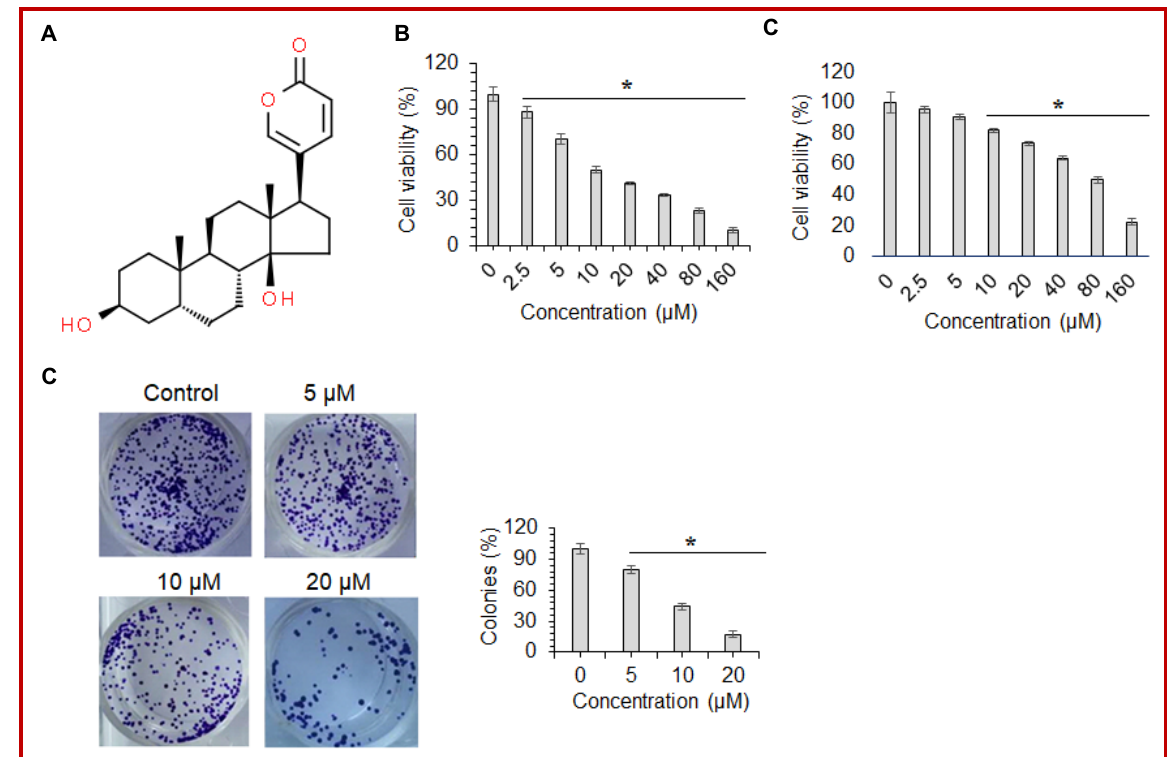
Figure 1: Bufalin exhibits selective antiproliferative activity against gastric cancer cells. (A) Chemical structure of bufalin; (B) CCK- 8 viability analysis of MGC-803 gastric cancer cells incubated with different doses (in µM) of bufalin at 37ºC for 24 hours; (C) CCK- 8 viability analysis of GES-1 gastric epithelial cells incubated with different doses (in µM) of bufalin at 37ºC for 24 hours (C) evalu- ation of colony formation from MGC-803 cancer cells incubated without or with 5, 10 or 20 µM bufalin; (D) relative percentage of colonies formed by MGC-803 cancer cells incubated without or with 5, 10 or 20 µM bufalin. The experiments were performed in three biological replicate and the results are shown as mean ± SD (*p<0.05)